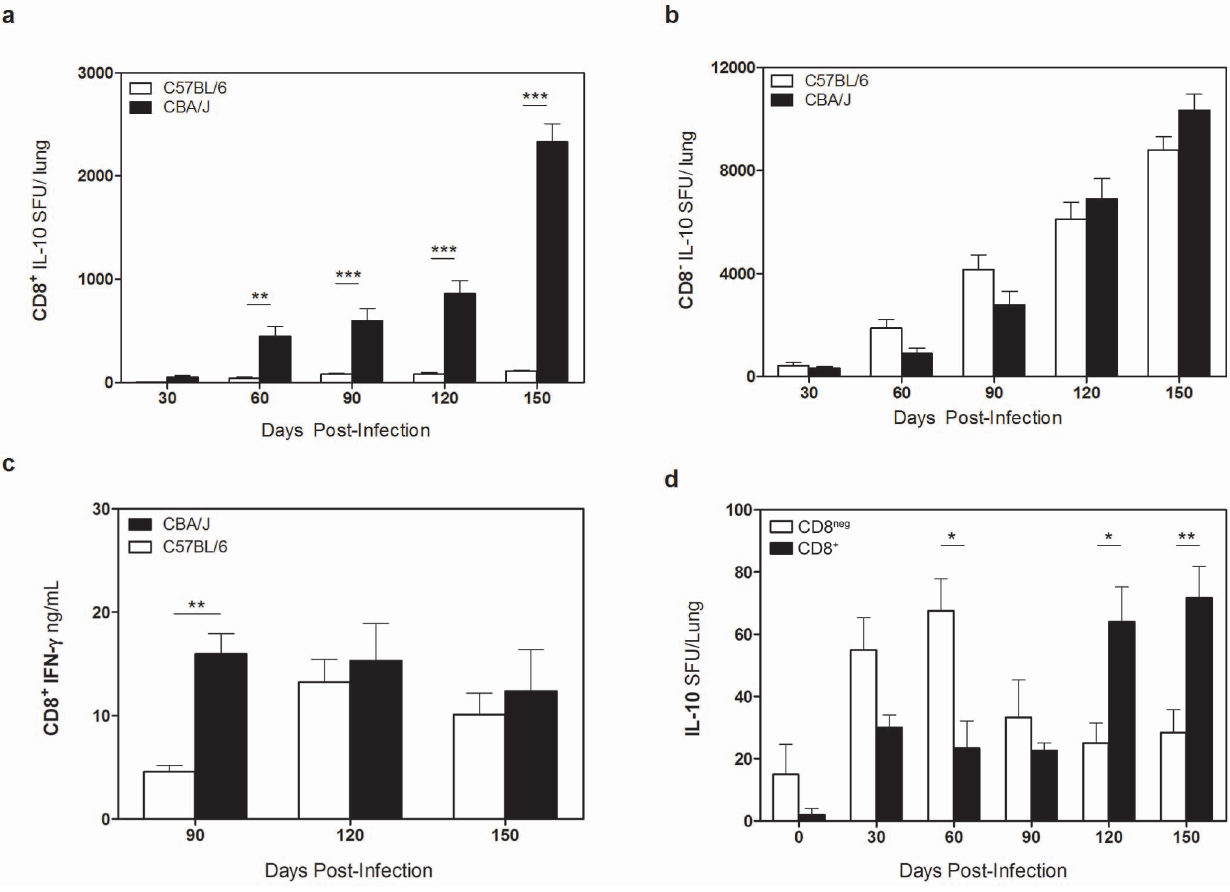
Figure 3. IL-10 production by CD8 + T cells from CBA/J mice. C57BL/6 and CBA/J mice were infected with an aerosolized dose of Mtb and at various times post-infection lungs were removed and cell populations were purified. Spot-forming units (SFU) representing the absolute number of IL-10 + CD8 + T cells ( a ) or CD8 neg T cells ( b ) per lung after 72 hr culture with anti-CD3/CD28. ( c ) Supernatants from (a) were analyzed for IFN- c levels by ELISA. ( d ) SFU per lung of CBA/J IL-10 + CD8 + or CD8 neg T cells cultured with Mtb -infected BMDCs for 72 hr. Data representative of two independent experiments with 4 mice per group per timepoint, * p , 0.05, ** p , 0.01, *** p , 0.001 as obtained by Student’s t test.